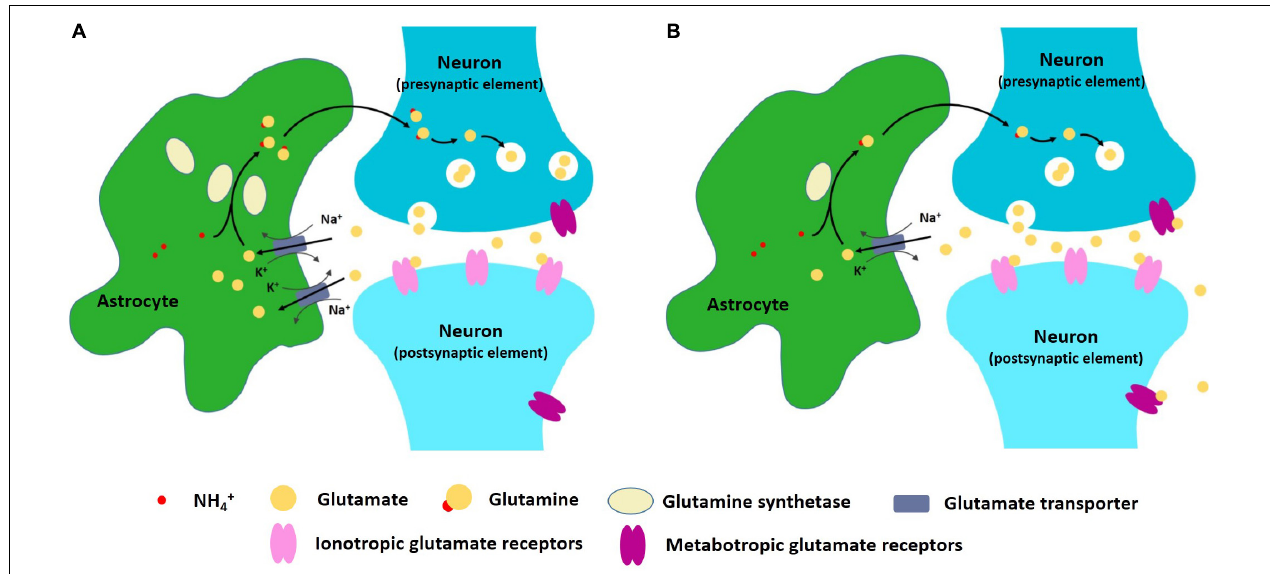
FIGURE 1 | (A) Astrocytes can take up, metabolize, and recycle glutamate that is released into the synapses. (B) In depression and anxiety disorder conditions, astrocyte dysfunction may lead to excitatory–inhibitory imbalance within neural